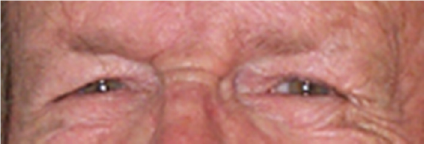
Figure 19. The effect of aging over the eye region.